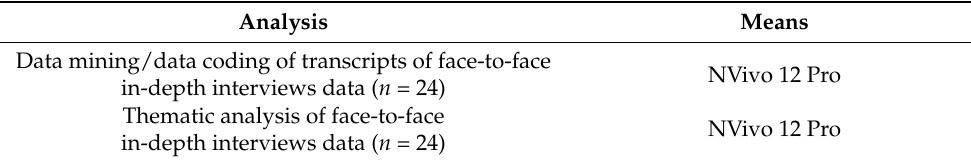
Table 1. Phases of data